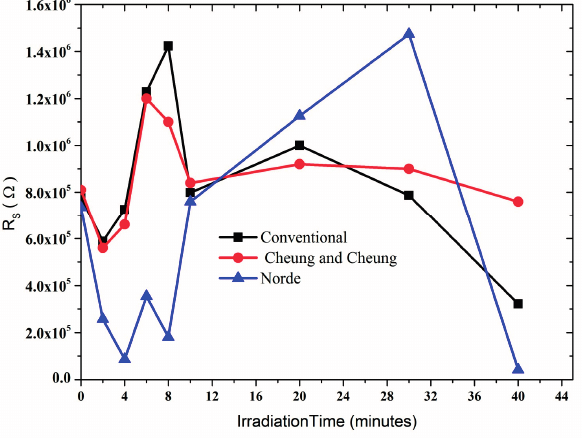
Figure 6. Graphs explaining the relationship between series resistance and alpha radiation time.